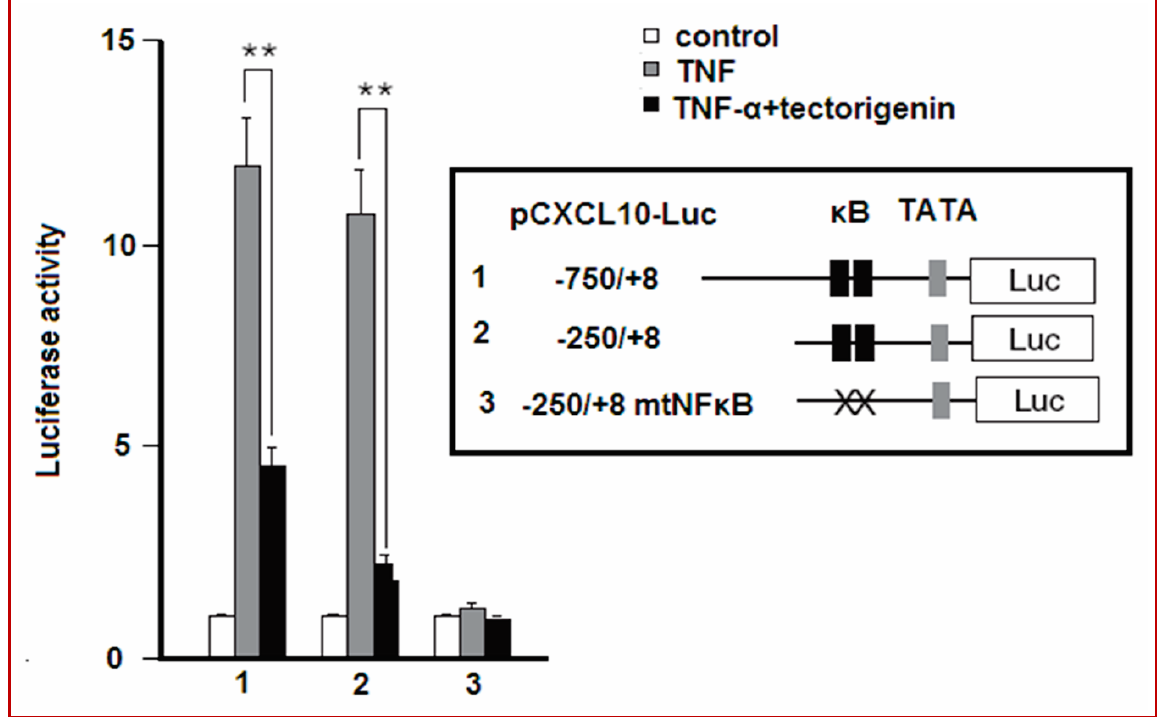
Figure 5: TNF- α induced CXCL-10 promoter activity. Treatment of Caco-2 cells with 10 ng/mL TNF- α or TNF- α plus tectorigen- in (20 µM) for 8 hours and firefly luciferase activity was measured and normalized to Renilla activity. All the data shown indicat- ed the mean ± SD for one experiment performed in